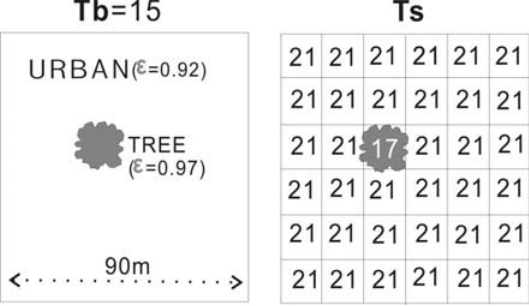
Figure 3. The effect of pixel block membership on fragmented land cover types in Emissivity